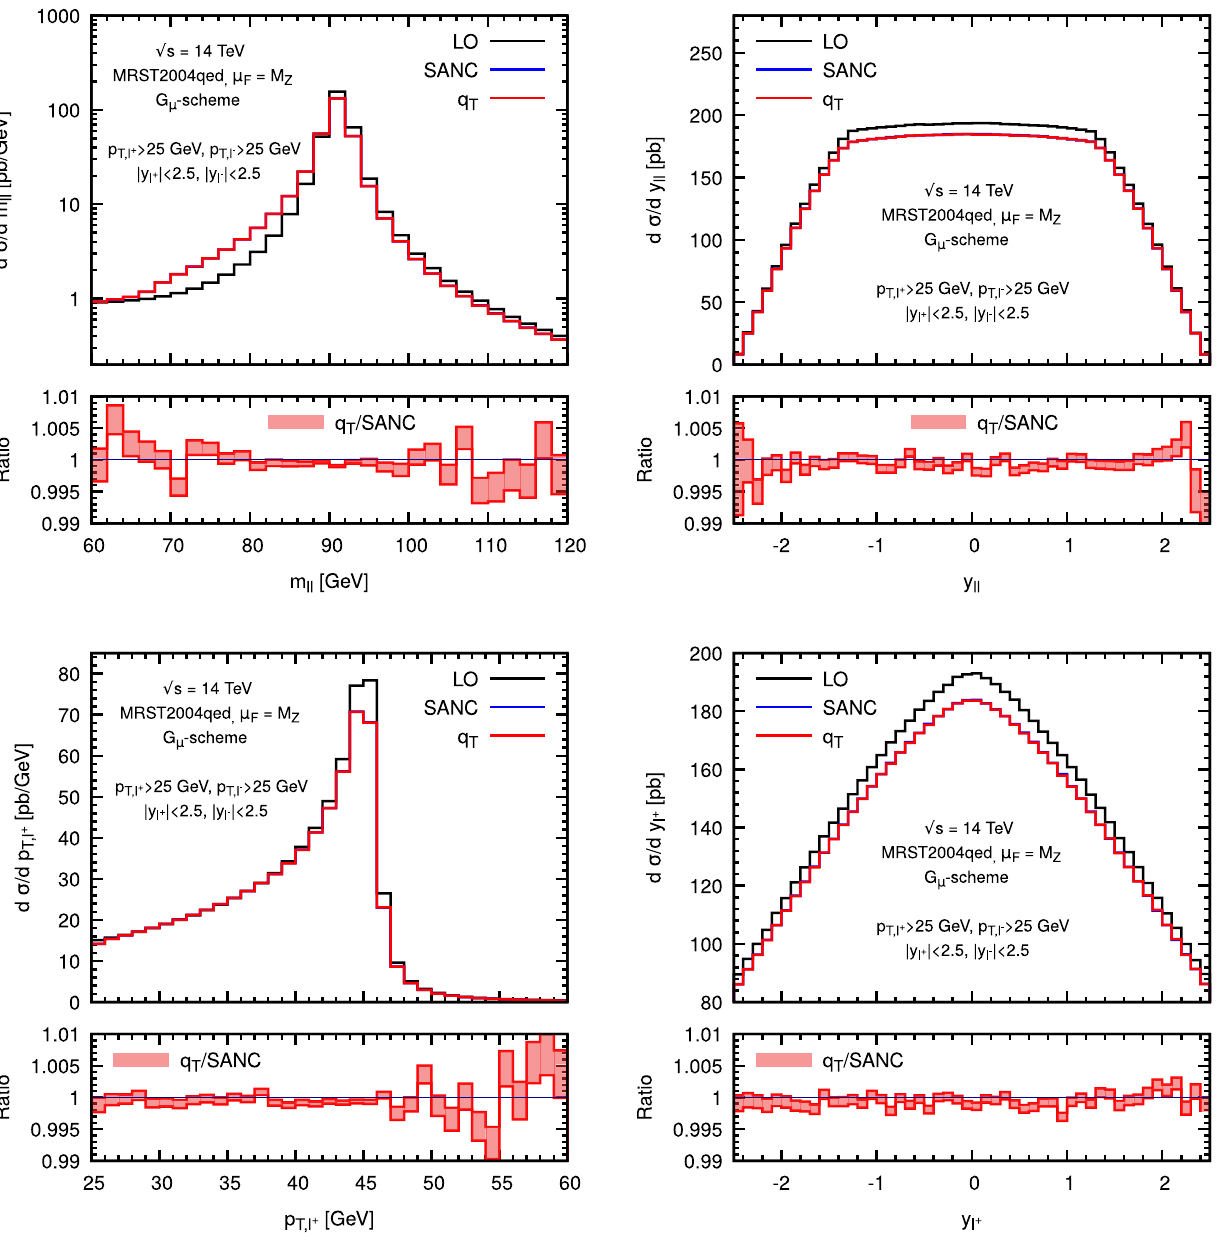
Fig. 1 Tuned comparison for the dilepton invariant mass distribution (top left), rapidity distribution (top right), p T distribution of the pos- itively charged lepton (bottom left) and rapidity distribution (bottom